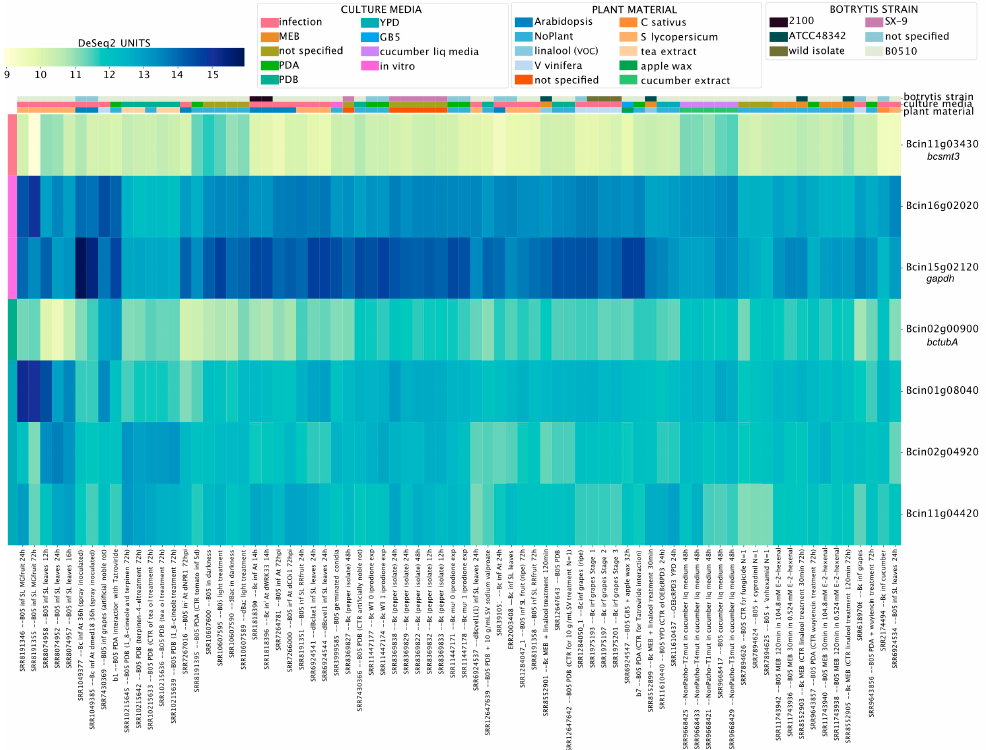
Figure 8. Transcript levels of previously validated reference genes employed in RT-qPCR studies of B. cinerea . The heatmap depicts transcript levels obtained using BEB, with a continuous color scale from yellow to dark blue indicating low or high expression, respectively. A detailed description of each experiment is provided at the bottom of the heatmap. Experimental conditions and genes are depicted in columns and rows, respectively. Gene IDs are provided at the right of the heatmap.